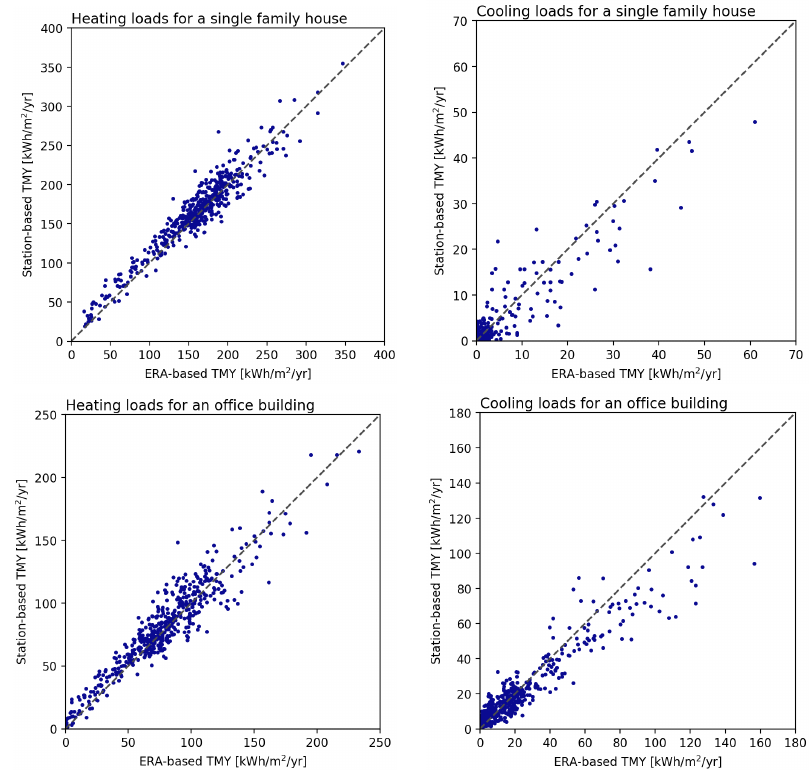
Figure 11. Scatterplots showing heating ( left ) and cooling ( right ) requirements as calculated by EnergyPlus using either the ERA-based TMY or the station-based TMY data. Results are shown for the single-family house ( top ) and the office building ( bottom ). Note that the scale of the plots